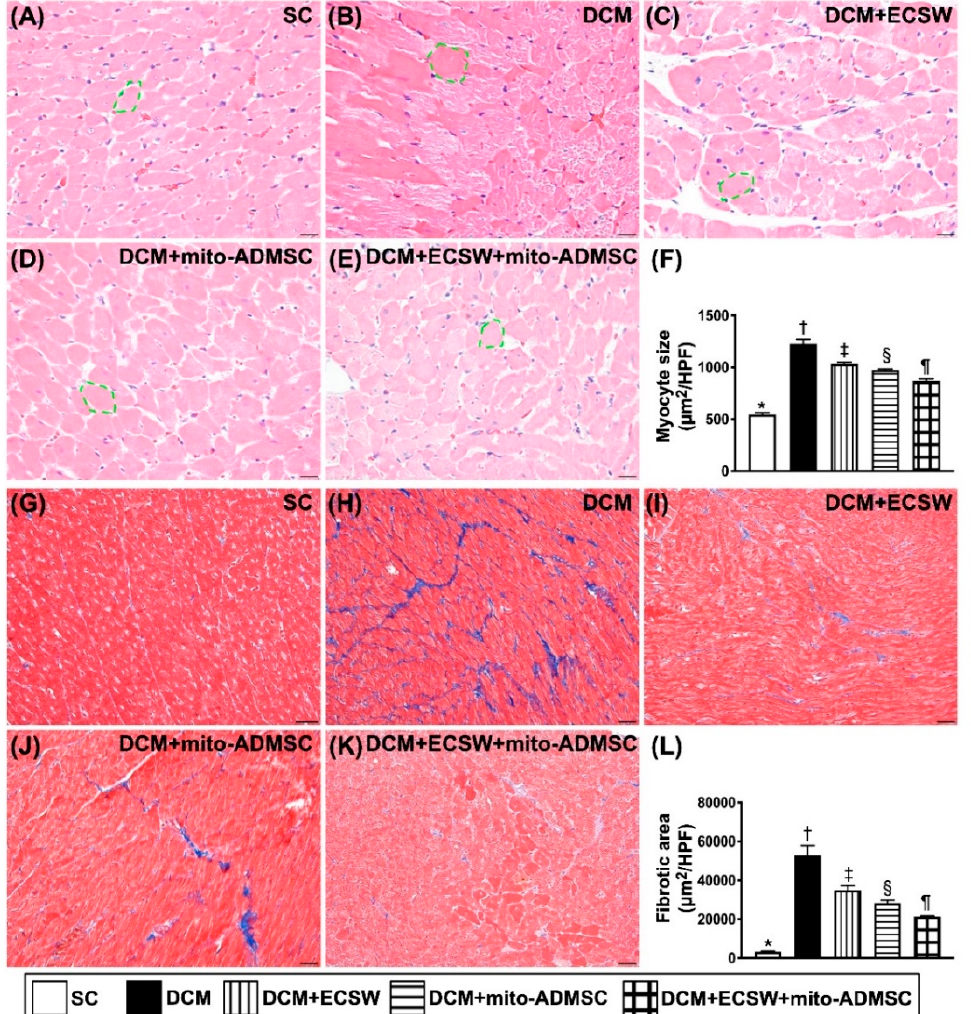
Figure 10. Cardiomyocyte size and cellular expression of fibrosis by day 49 after DCM induction. ( A – E ) Illustrating the microscopic finding (200 × ) of H.E. stain for identification of cardiomyocyte size (yellow dotted line). ( F ) Analytical result of cardiomyocyte size, * vs. other groups with different symbols (†, ‡, §, ¶), p < 0.0001. ( G – K ) Illustrating the immunohistochemical stain (200 × ) for identi- fication of fibrosis in LV myocardium (blue color). ( L ) Analytical result of fibrotic area, * vs. other groups with different symbols (†, ‡, §, ¶), p < 0.0001. Scale bar in right lower corner represents 50 µ m. All statistical analyses were performed by one-way ANOVA, followed by Bonferroni mul- tiple comparison post hoc test ( n = 6 for each group). Symbols (*, †, ‡, ¶) indicate significance (at 0.05 level). SC = sham control; DCM = dilated cardiomyopathy; ECSW = extracorporeal shock wave; mito =